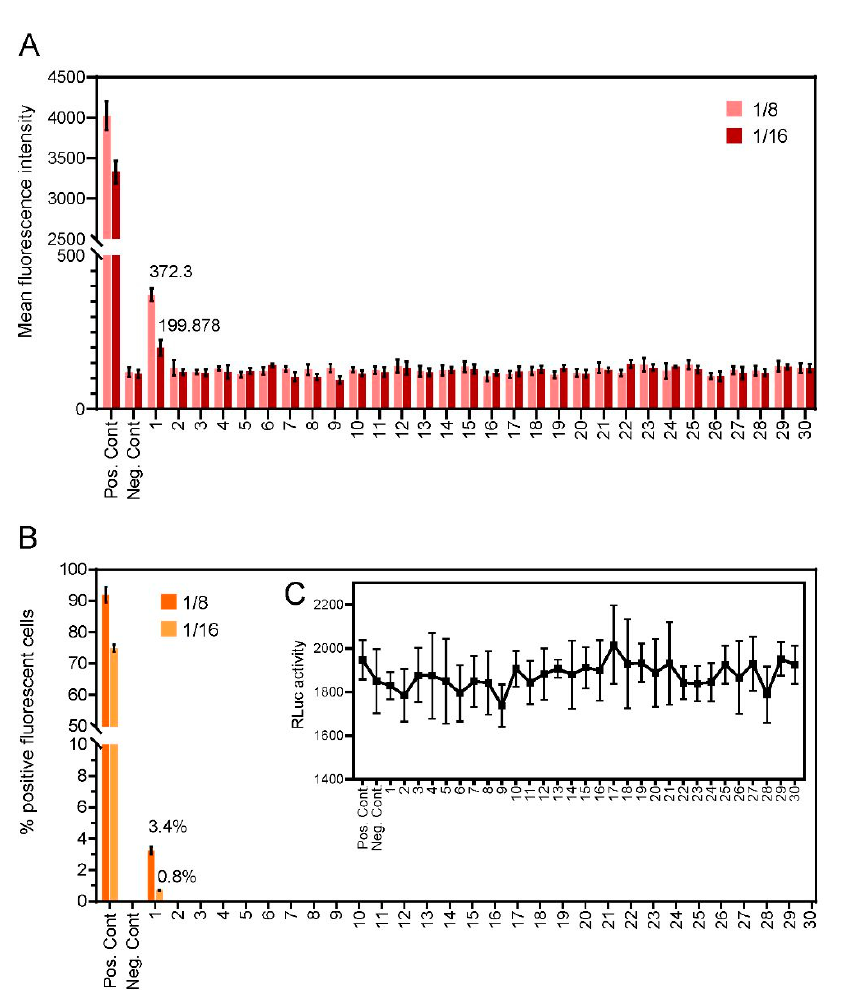
Figure 4. Levels of anti-SARS-CoV-2 IgG antibodies detected through the C19-S-I-IFA assay in the sera from thirty volunteer donors. ( A ) Bar heights represent mean fluorescence intensities for each dilution. ( B ) Percentage of fluorescent positive cells. ( C ) RLuc was used as an internal transfection control. Bar heights represent the mean of two biological replicates: error bars show SEMs.